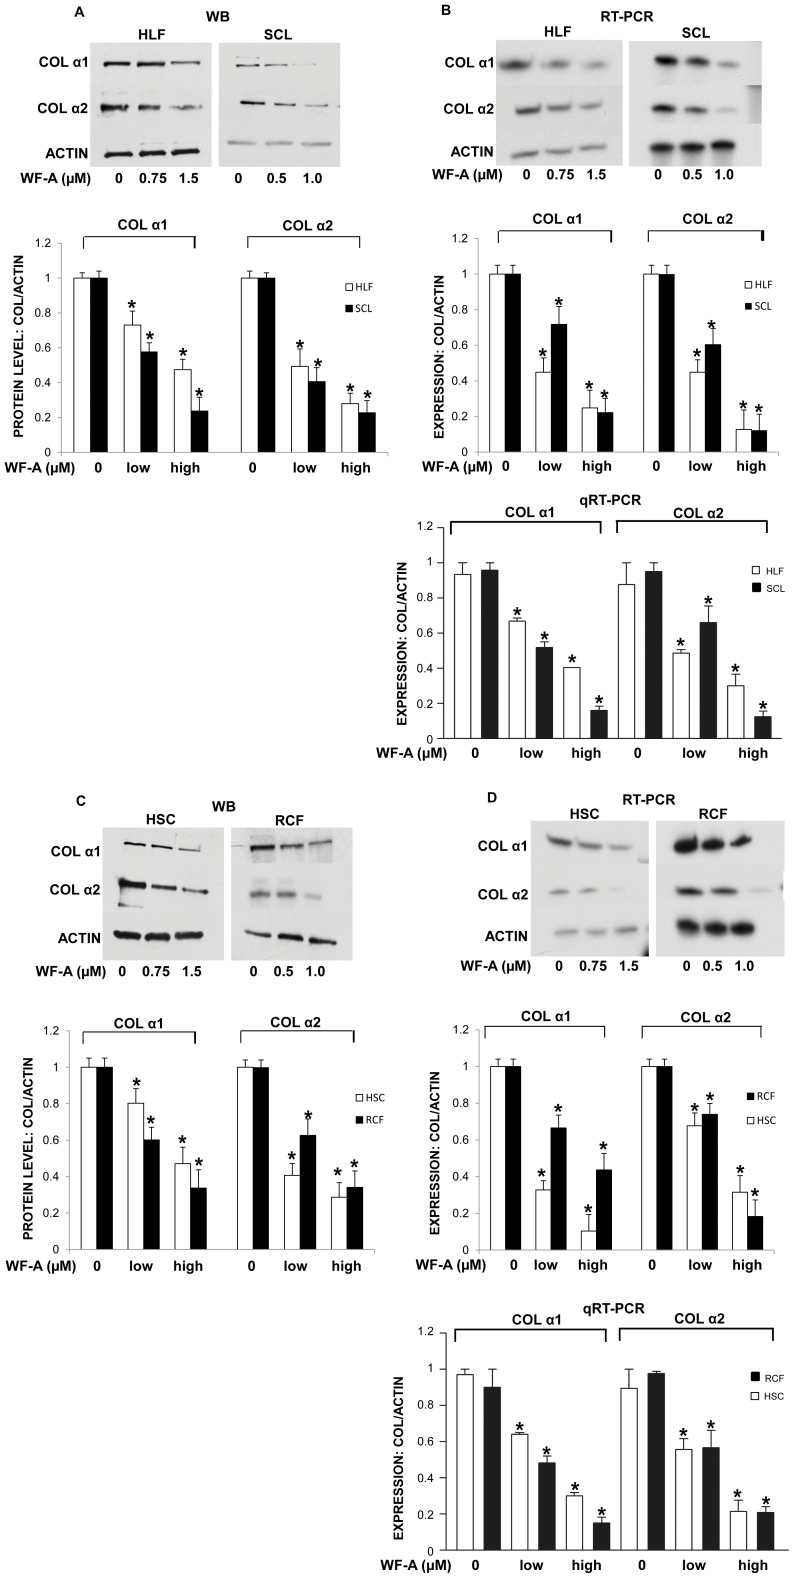
WF-A reduces expression of type I collagen α1 and α2 polypeptides and their mRNAs in human and rodent fibroblasts.A. WF-A reduces collagen type I protein in human fibroblasts. HLF (upper left panel) and SCL fibroblasts (upper right panel) were treated WF-A and cellular levels of collagen α1(I) (COLα1) and α2(I) (COLα1) polypeptides were analyzed by Western blotting. Loading control: actin. Bottom panels; the expression of collagen polypeptides were normalized to actin and plotted from three independent experiments. Open bars: HLF, black bars: SCL. Low concentrations of WF-A: (0.75 µM for HLF) and (0.5 µM for SCL). High concentrations of WF-A: (1.5 µM for HLF) and (1.0 µM for SCL). The error bars: ±1 SEM are shown. B. WF-A decreases the steady-state levels of collagen α1 and α2 mRNAs in human fibroblasts. Experiment as in A, mRNAs were analyzed by RT-PCR (upper panels). Middle panel is quantification of RT-PCR from three independent experiments, and the bottom panel show quantification by real time (qRT-PCR). C. WF-A reduces collagen protein in primary rat hepatic stellate cells (HSC) and primary rat cardiac fibroblasts (RCF). HSC and RCF were isolated from rat liver and heart, respectively, and treated with the indicated amounts of WF-A. Experiment as in A. Loading control: actin. Bottom panels: levels of collagen α1(I) (COLα1) and collagen α2(I) (COLα2) polypeptides were normalized to actin and plotted from three independent experiments. Open bars: HSC, black bars: RCF. Low concentrations of WF-A: (0.75 µM for HSC) and (0.5 µM for RCF). High concentrations: (1.5 µM for HSC) and (1.0 µM for RCF). The error bars: ±1 SEM are shown. D. WF-A decreases the steady-state levels of collagen mRNAs in HSC and RCF. Experiment as in C, mRNAs were analyzed by RT-PCR (upper panels, with quantification from three experiments shown in middle panel) and qRT-PCR (bottom panel), * represents p<0.05.